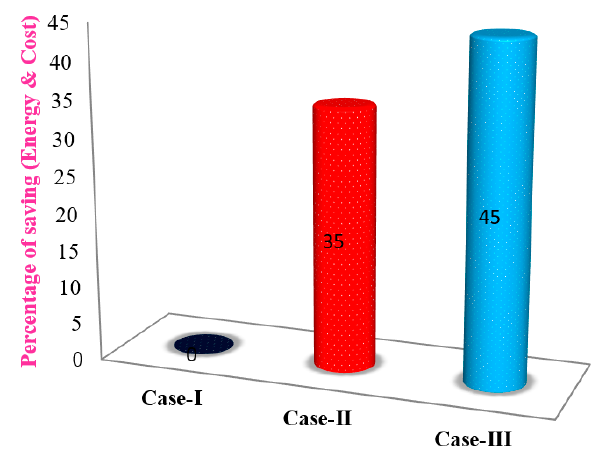
Figure 20. Comparison of the percentage of energy and cost saving for cases I, II and III.